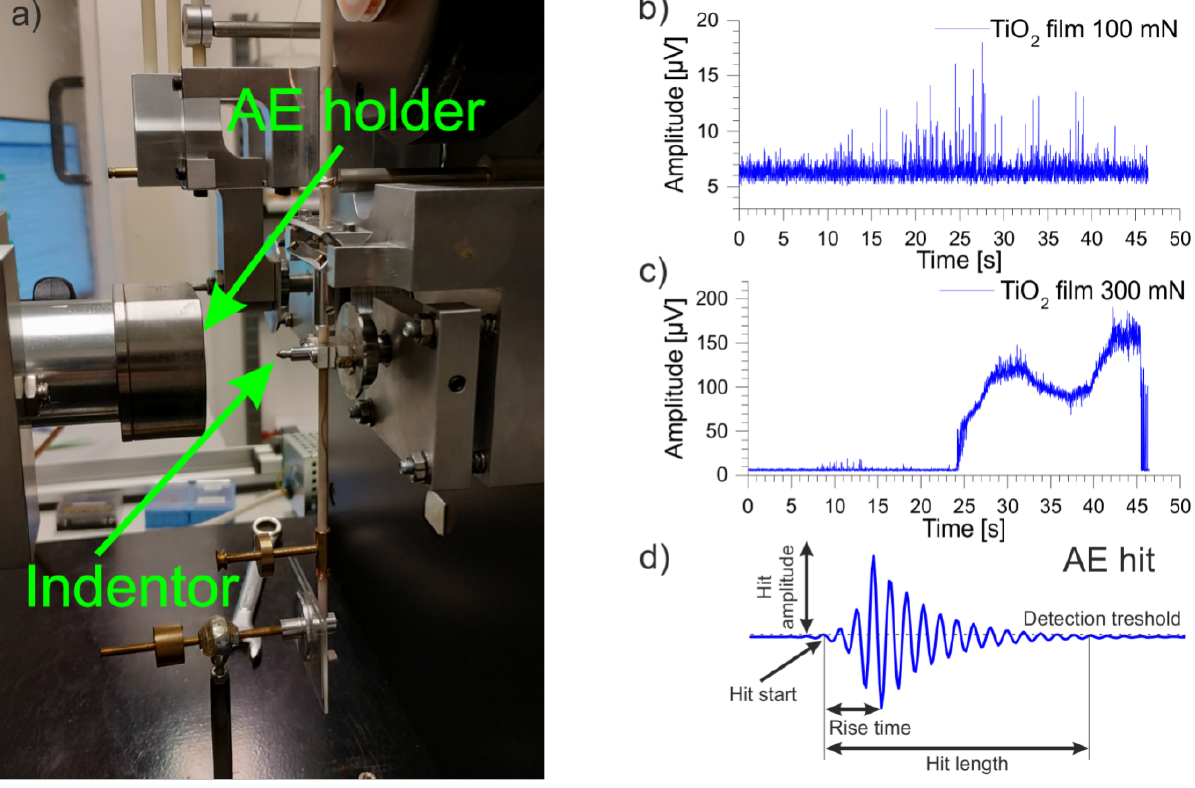
Figure 1. Acoustic emission: a) AE holder implemented in the NanoTest system, b) burst AE envelope, c) continuous AE envelope d) AE hit waveform; b) and c) represents data from thin optical film on glass substrate.